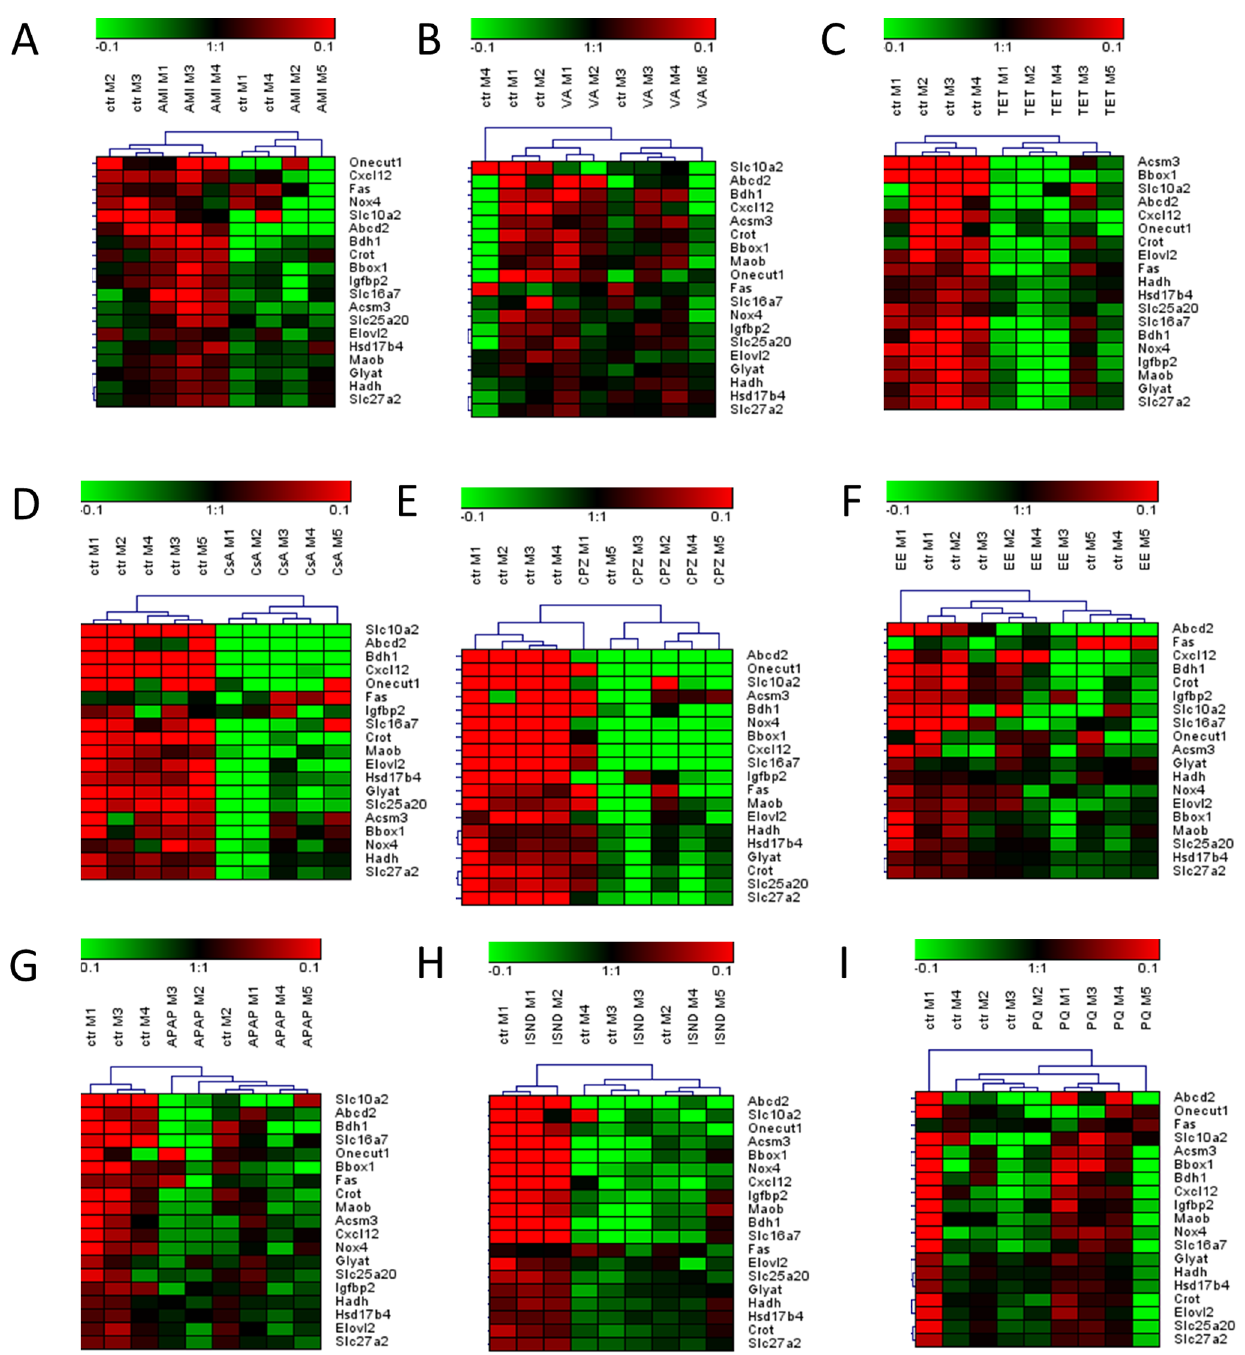
Figure 8. Identification of potential biomarkers for tetracycline-like acting compounds in mouse PCLS. PCLS obtained from 4 or 5 mice were exposed for 24 h to model toxicants for steatosis (amiodarone (A), valproic acid (B), or tetracycline (C)), cholestasis (cyclosporin A (D), chlorpromazine (E), or ethinyl estradiol (F)), necrosis (acetaminophen (G), isoniazid (H), or paraquat(I)), or controls. GSEA led to the identification of 19 genes downregulated by tetracycline (TET) treatment, which were considered as candidate biomarkers for TET-like acting compounds. mRNA expression values for the selected biomarkers are derived from DNA-microarrays, and results are presented as heat maps of log2, median centered gene expression values subjected to HCA. For explanation of the colours and abbreviations see Figure